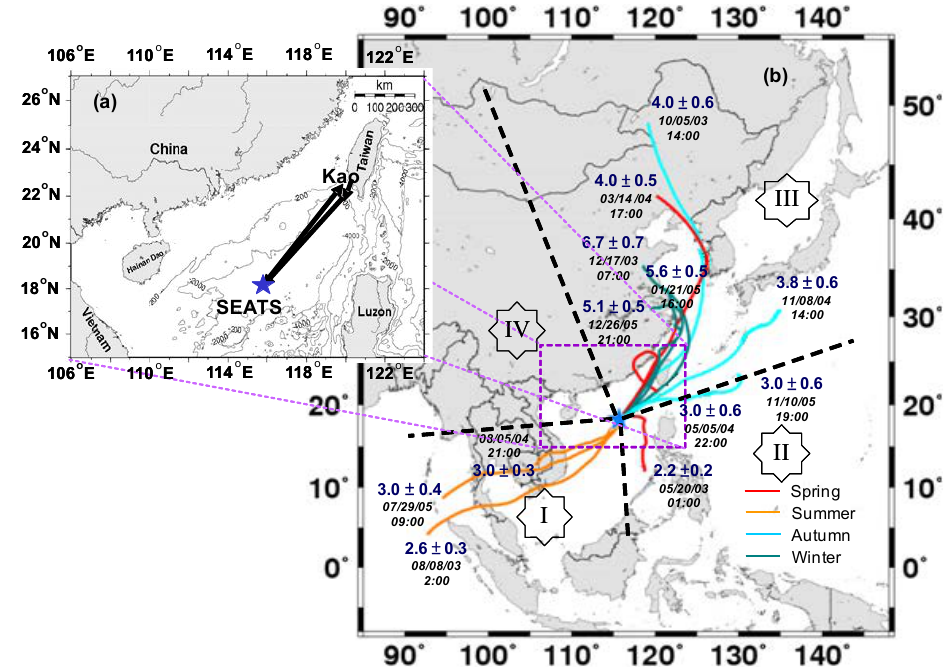
Fig. 1. (a) Sampling site of the South-East Asian Time-series Study (SEATS) station in the northern South China Sea (SCS) with routine cruise tracks (arrow) between the Kaoshiung (kao) and the SEATS station (star); (b) the 3-day backward trajectories started at the mid-way time of the cruise at the SEATS station with average GEM concentrations and marked four general air-advection groups: (I) Southwest monsoon with prevailing SW wind; (II) Inter-monsoon and others (e.g., typhoon) with ENE-E-S wind sector; (III) Northeast monsoon with prevailing NE wind and (IV) air masses from south China with E-NW wind